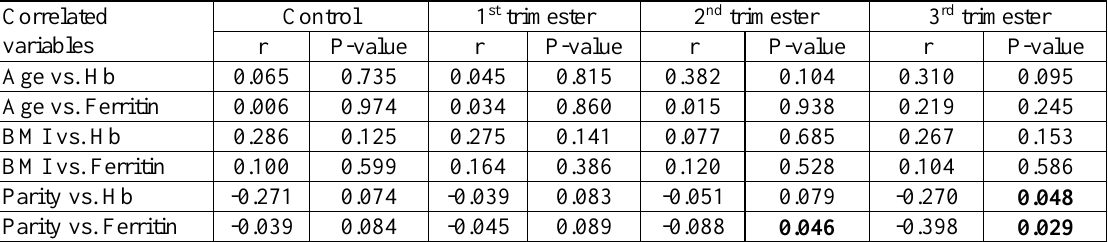
Table 4. Correlation tests of age, parity and BMI with blood Hb concentrations and serum ferritin levels of the study